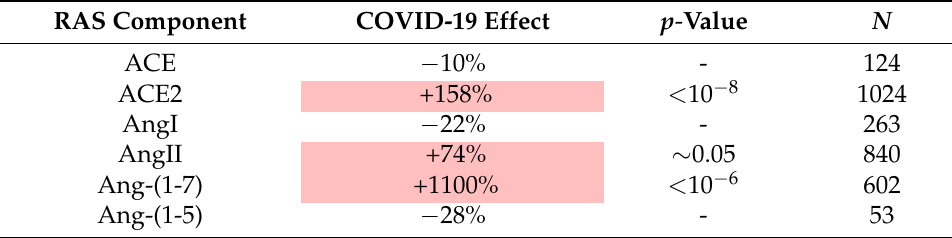
Table 1. Average change (in %) of the serum concentration of RAS components between COVID-19 patients and controls. The averages were performed over all the studies collected in this paper and weighted according to the number of patients/controls in each study. p -Values were computed using the Stouffer method and are reported only when statistically significant ( p ≤ 0.05). N is the total number of patients and controls. Increased levels are indicated on a pink background. See Supplementary Table S1 for the exact values in each